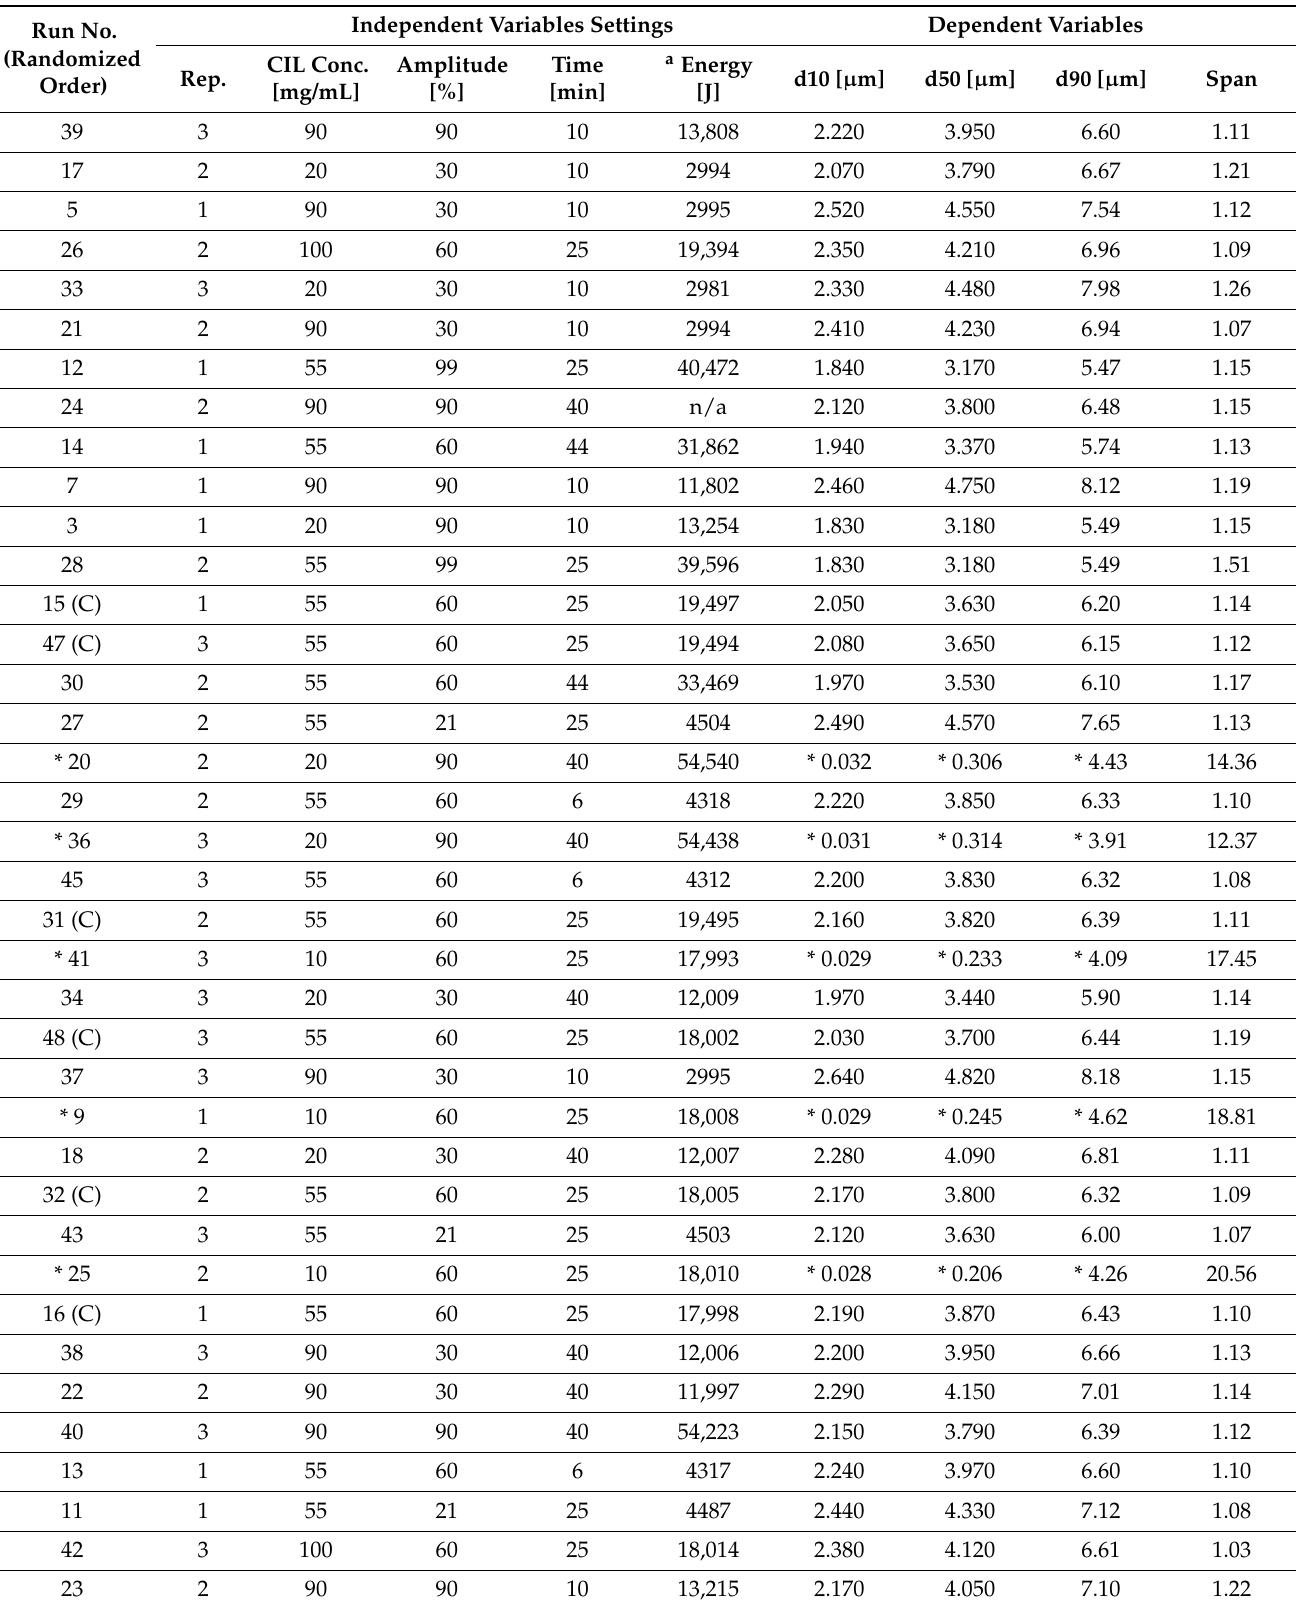
Table 3. Independent variable settings and results of central composite design experiments used in LASP+sonication optimization and